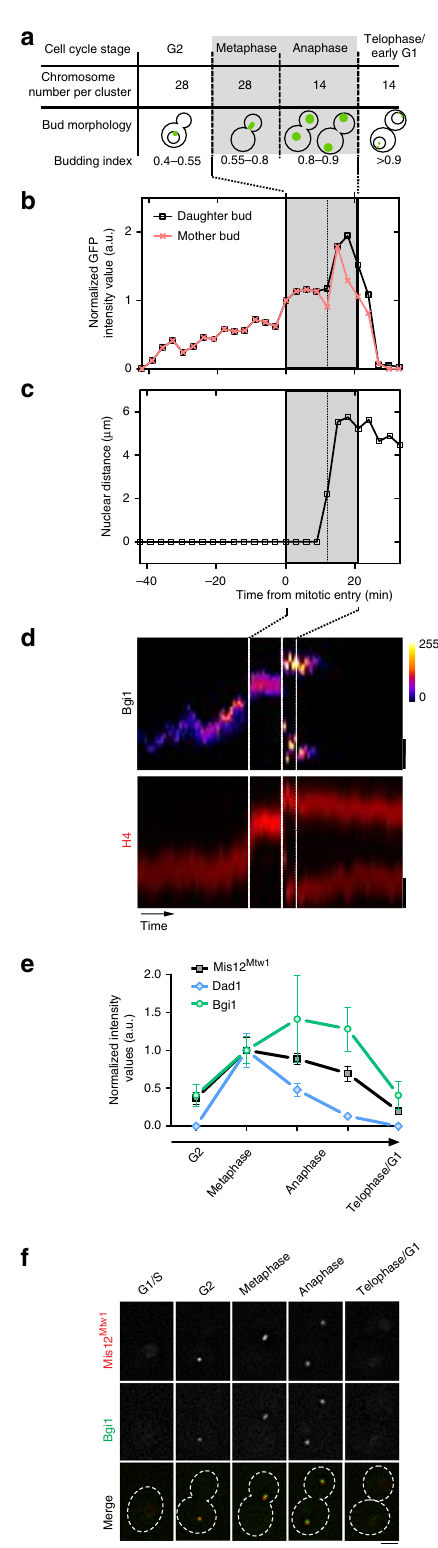
Fig. 3 Bridgin reaches its peak concentration at the kinetochore during anaphase. a Expected chromosome number per kinetochore cluster in the haploid-type strain H99/KN99 and spatial location of bridgin (green) with the corresponding budding index is tabulated. b Signal intensity measurements of Bgi1 in a single cell of the strain SHR843 ( BGI1::BGI1-V5- GFP, H4::H4-mCherry) , at an interval of 3 min were measured